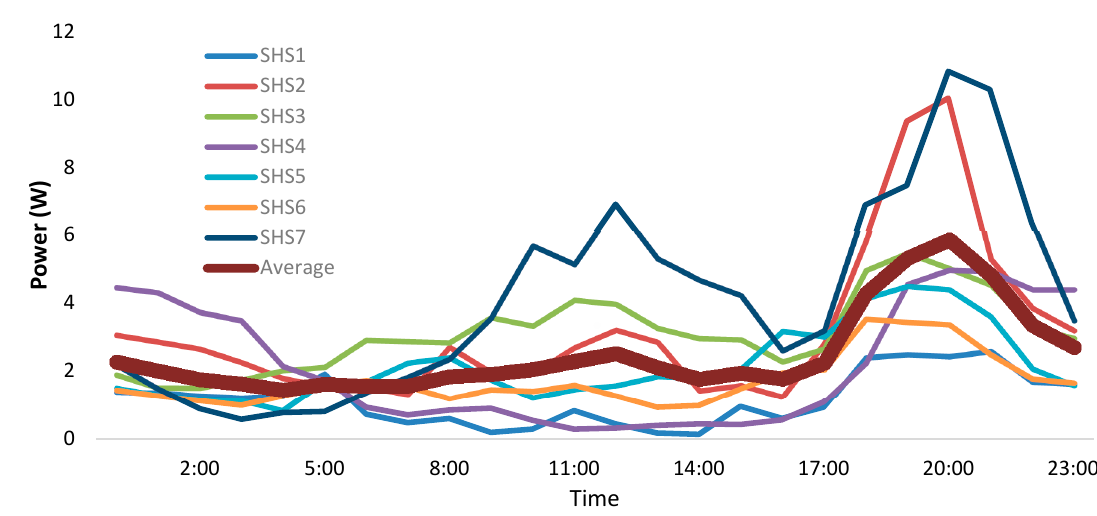
Figure 4. Demand Profiles for BBOXX SHSs.